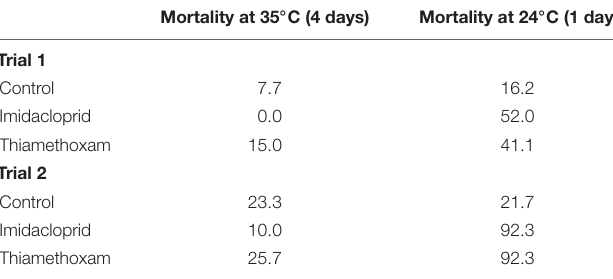
Paired t-test (not including control bees) showed a significant difference between the two temperatures (P = 0.018), despite of the fact that the mortality of 35 ◦ C was during 4 days and those at 24 ◦ C were for 1 day